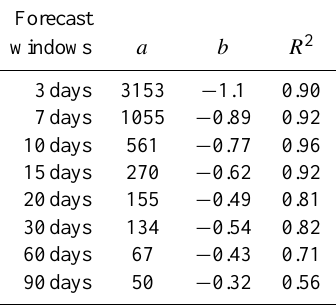
Table 4. Parameters of the exponential function and the R 2 value in the relationships of β and the forecast